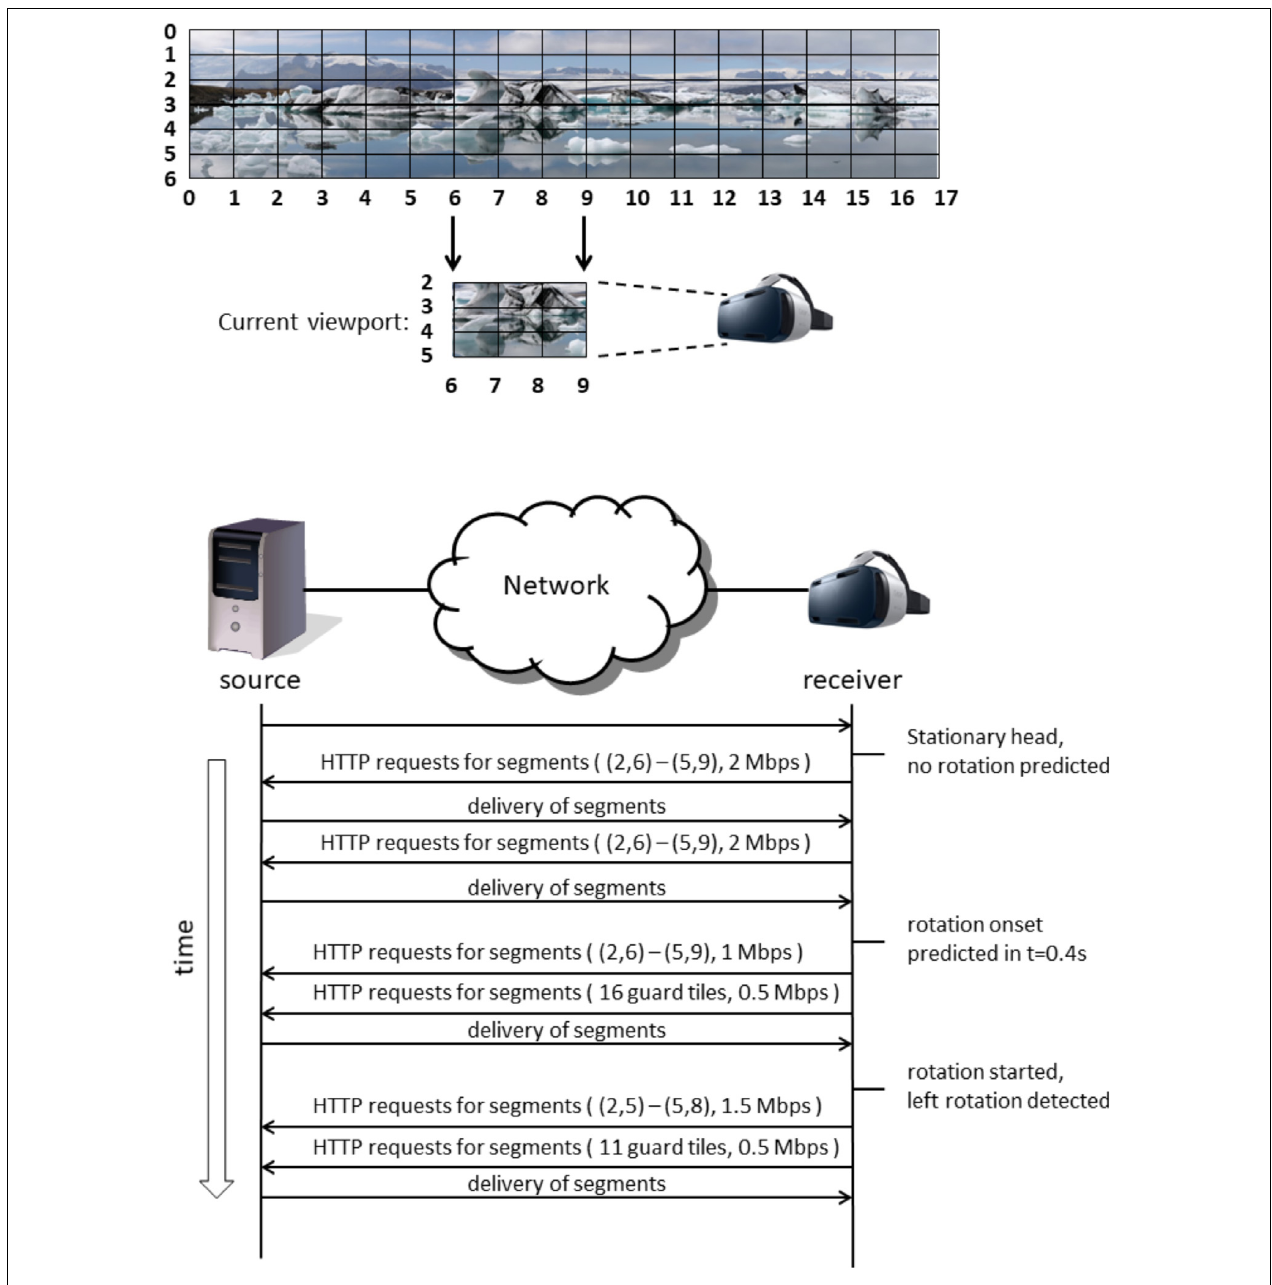
FIGURE 2 | Schematic representation of a streaming process over time, integrating prediction, and detection of head